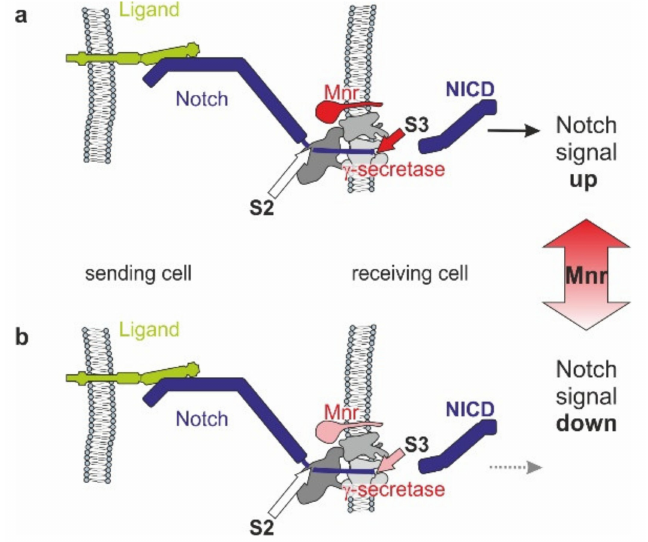
Figure 9. Role of Mnr in Notch signaling. ( a ) The sending cell (left) presents the Notch ligand, which binds to the Notch receptor on the signal-receiving cell. The resultant pulling force opens up the S2 cleavage site within the Notch-repressor region for the ADAM metalloprotease. In consequence of extracellular proteolysis, γ -secretase (in grey, composed of four subunits [71]) induces S3 cleavage of the Notch receptor within the membrane, thereby releasing the biologically active NICD fragment conveying the Notch signal. Mnr (in red) supports γ -secretase activity. ( b ) In case of decreased Mnr activity, γ -secretase activity is lowered and so is Notch signal transduction. Hence, increased Mnr levels cause Notch signals to go up, whereas lower Mnr levels reduce Notch signaling activity. Supplementary Materials: The following are available online at https://www.mdpi.com/article/10 .3390/biom11111672/s1, Figure S1: Mnr encodes two classes of membrane-bound proteins, Figure S2: RNAi mediated knockdown of mnr expression by v43699 overexpression in the eye, Figure S3: Co-localization of Mnr protein with Notch and Delta, Figure S4: RNAi mediated knockdown of mnr expression in S2